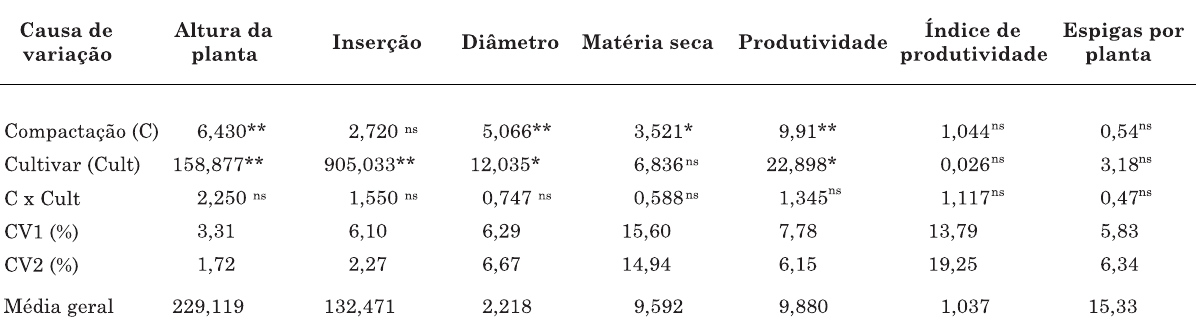
CV1 (%): coeficiente de variação referente ao fator compactação; CV2 (%): coeficiente de variação referente ao fator